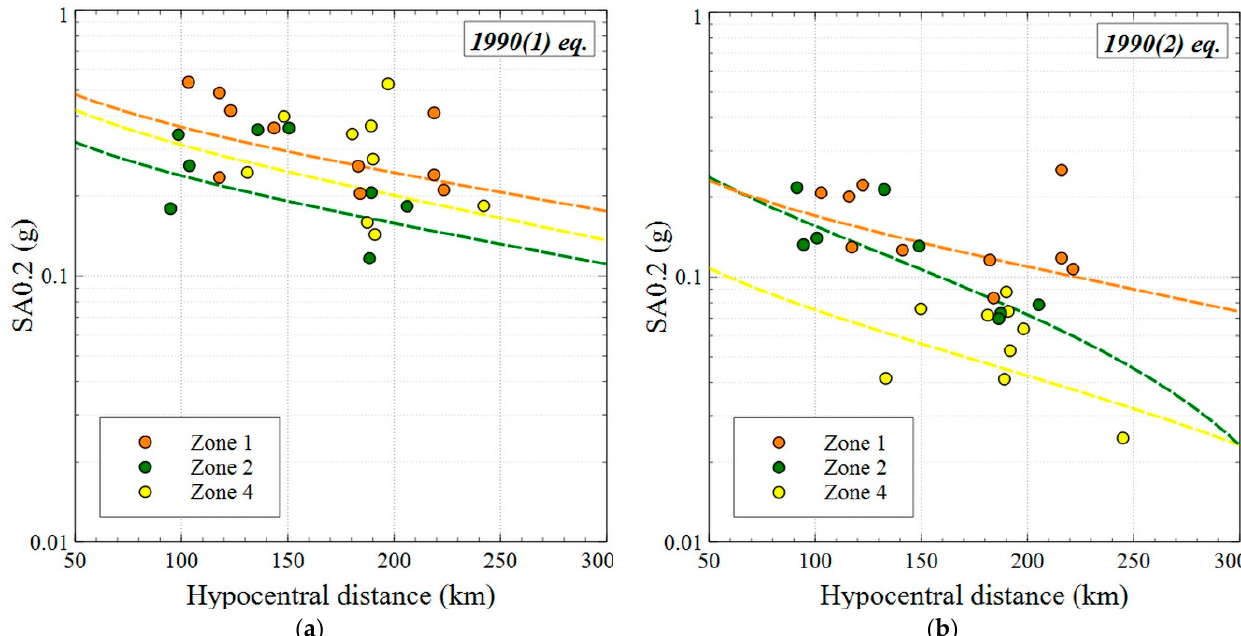
Figure 10. Comparison between the hypocentral distance attenuation curves for the spectral acceleration at 0.2 s for: ( a ) the 1990(1) Vrancea earthquake; ( b ) the 1990(2) Vrancea earthquake. With dashed lines are shown the corresponding logarithmic fit curves.